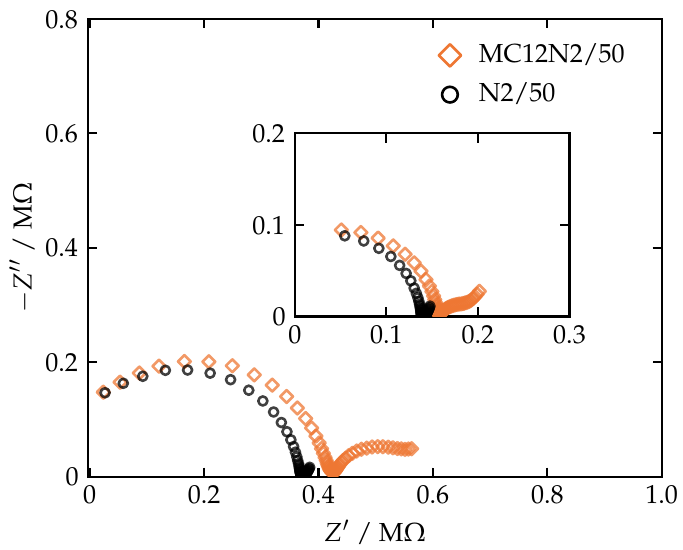
Figure 2. Impedance spectra of sensors with either the best-performing ion-selective membrane or its corresponding control membrane. PVC-shelled sensors are shown in the main plot and PCTFE-shelled sensors in the inset. Measurements were performed in 10 − 1 M sodium acetate with the parameters f = 100mHz–100kHz, E dc = 0V vs. OCP, and ∆ E ac = 100mV ( RMS ) . See Table 1 for membrane compositions.